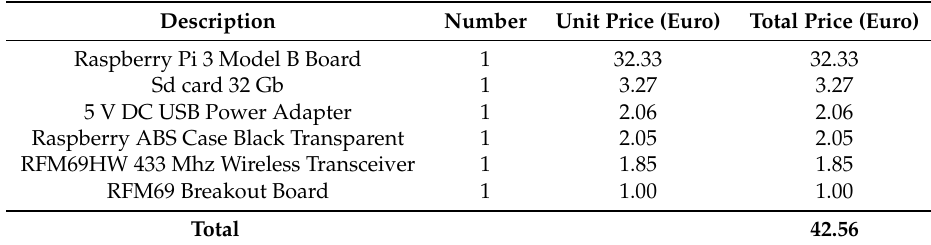
Table 5. Gategaway node